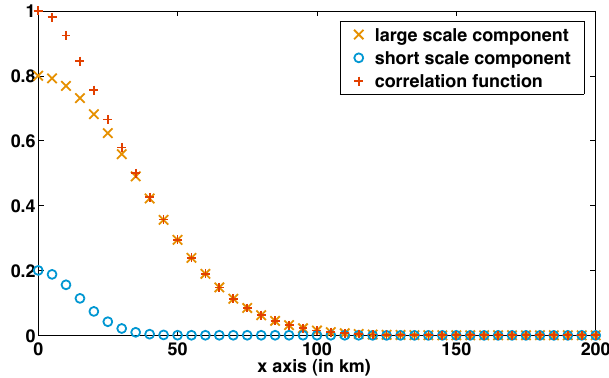
Fig. 6. Correlation function (in red crosses) used for the generation of initial bedrock topography ensembles. This is a combination of two Gaussian functions: one to capture large-scale behaviour (or- ange x) and one for short-scale behaviour (cyan circles).